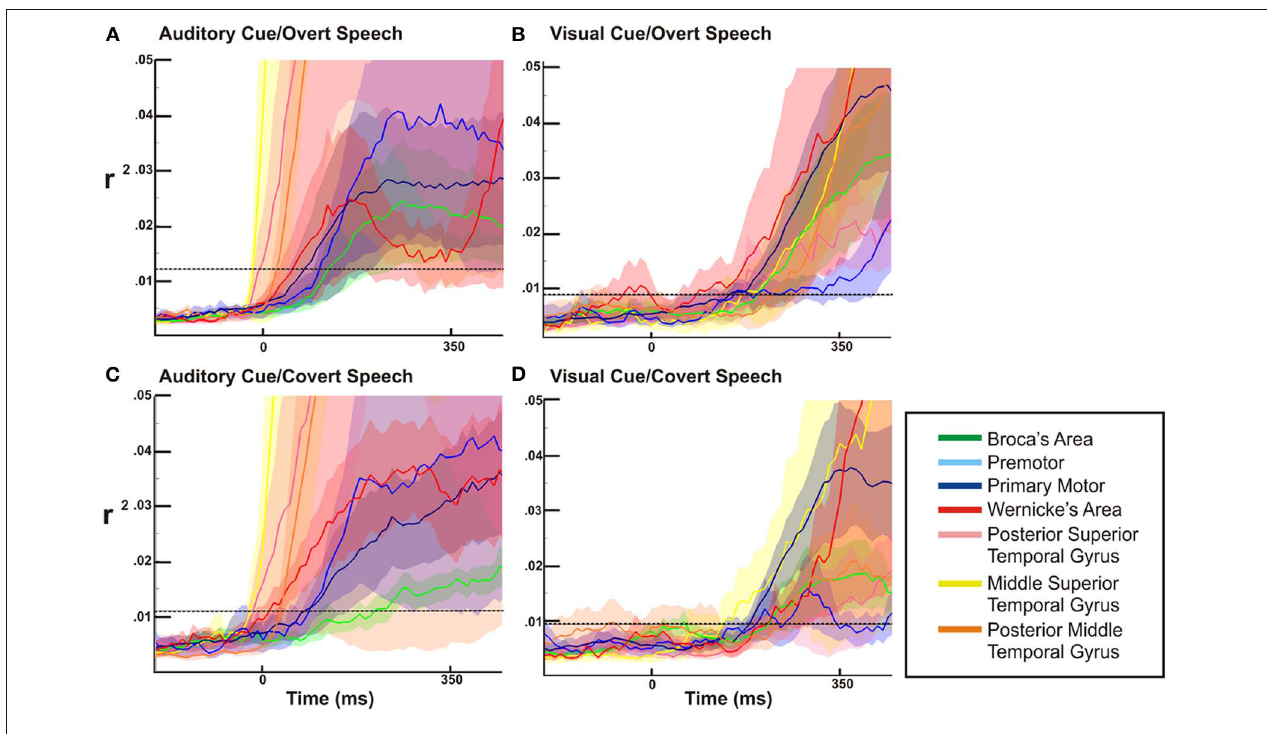
FIGURE 6 | ECoG high gamma r 2 time courses as a function of time relative to auditory or visual stimulation. The dotted line represents the statistical threshold for significance ( p < 0 . 03). In all four